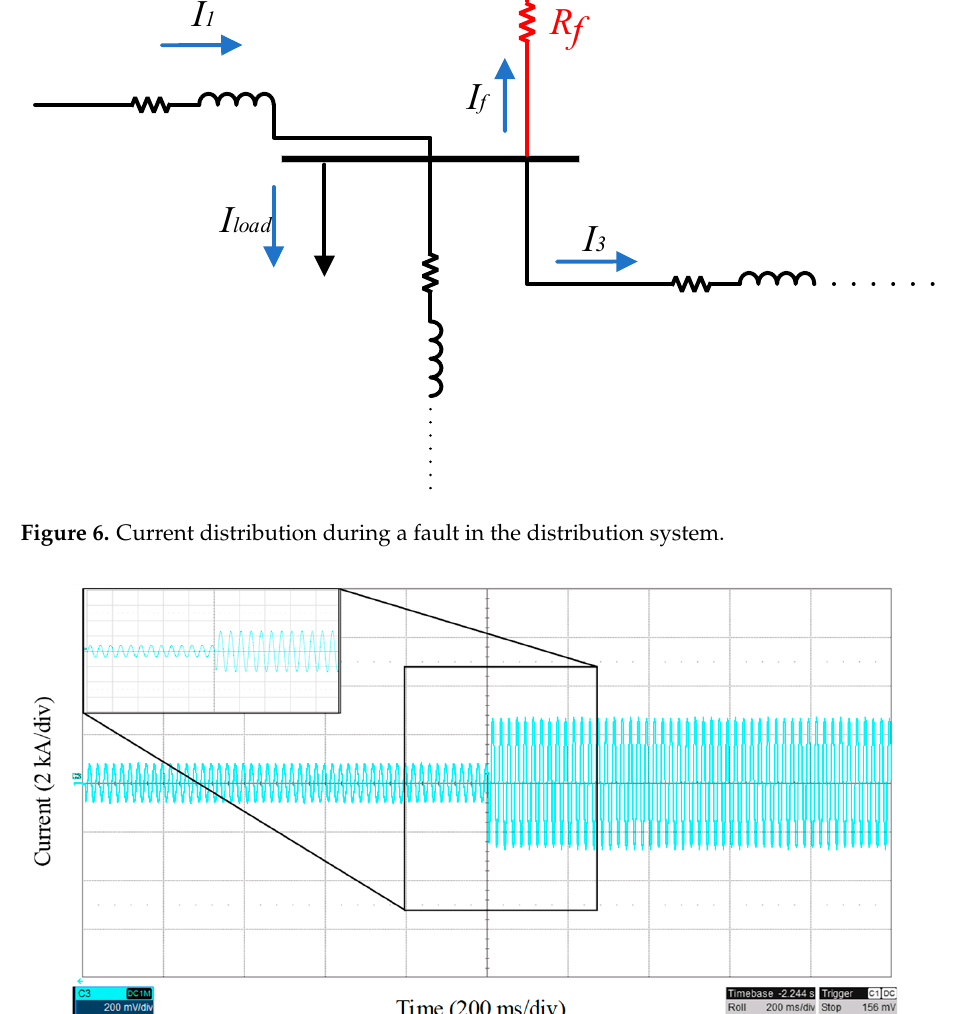
Figure 6. Current distribution during a fault in the distribution system.